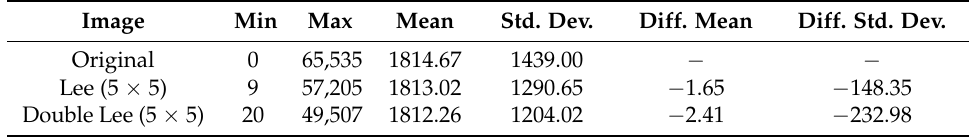
Figure 5. Visualisation of noise reduction using ( a ) single and ( b ) double Lee filters. Table 2. Quantitative details of synthetic aperture radar (SAR) pixels in noise reduction procedures.